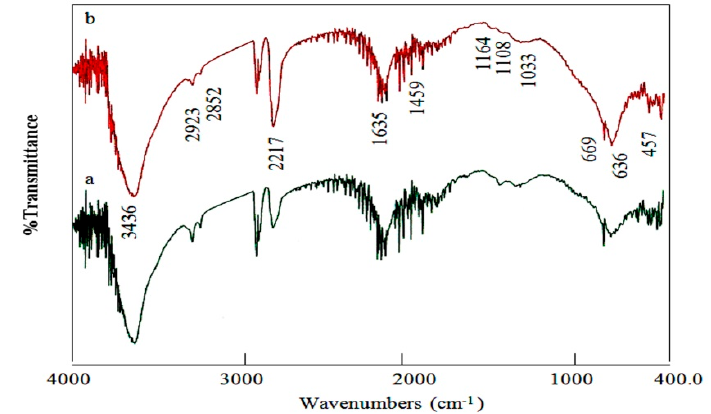
Figure 4. Infrared spectra of Ni-Ti-4 LDHs after reaction times: ( a ) 10 h and ( b ) 19 h.